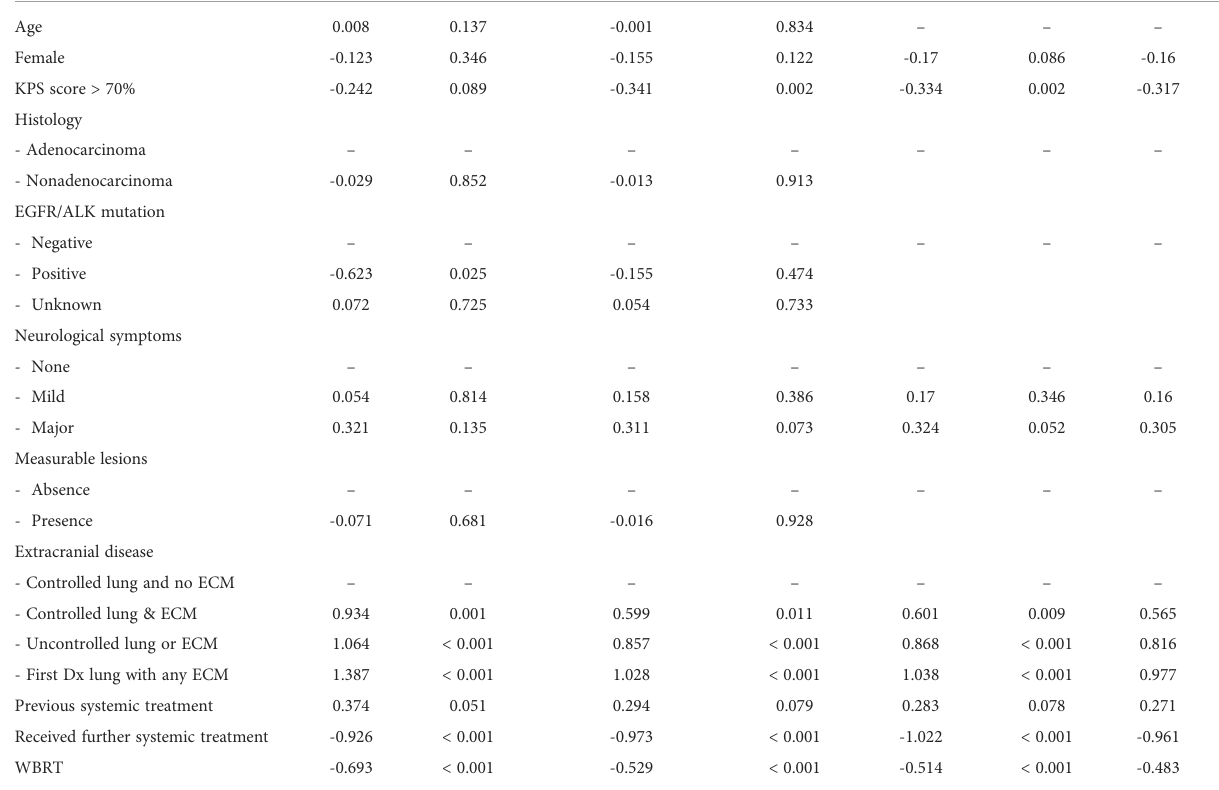
TABLE 2 Comparison of model ’ s coef fi cients.